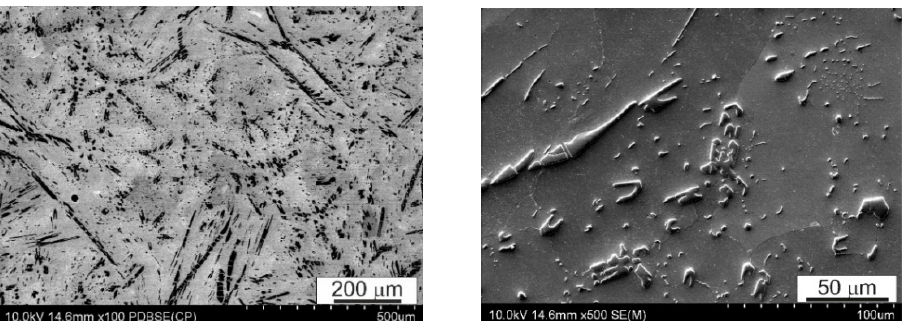
Figure 3. Microstructure of B89 alloy in its initial state, SEM.